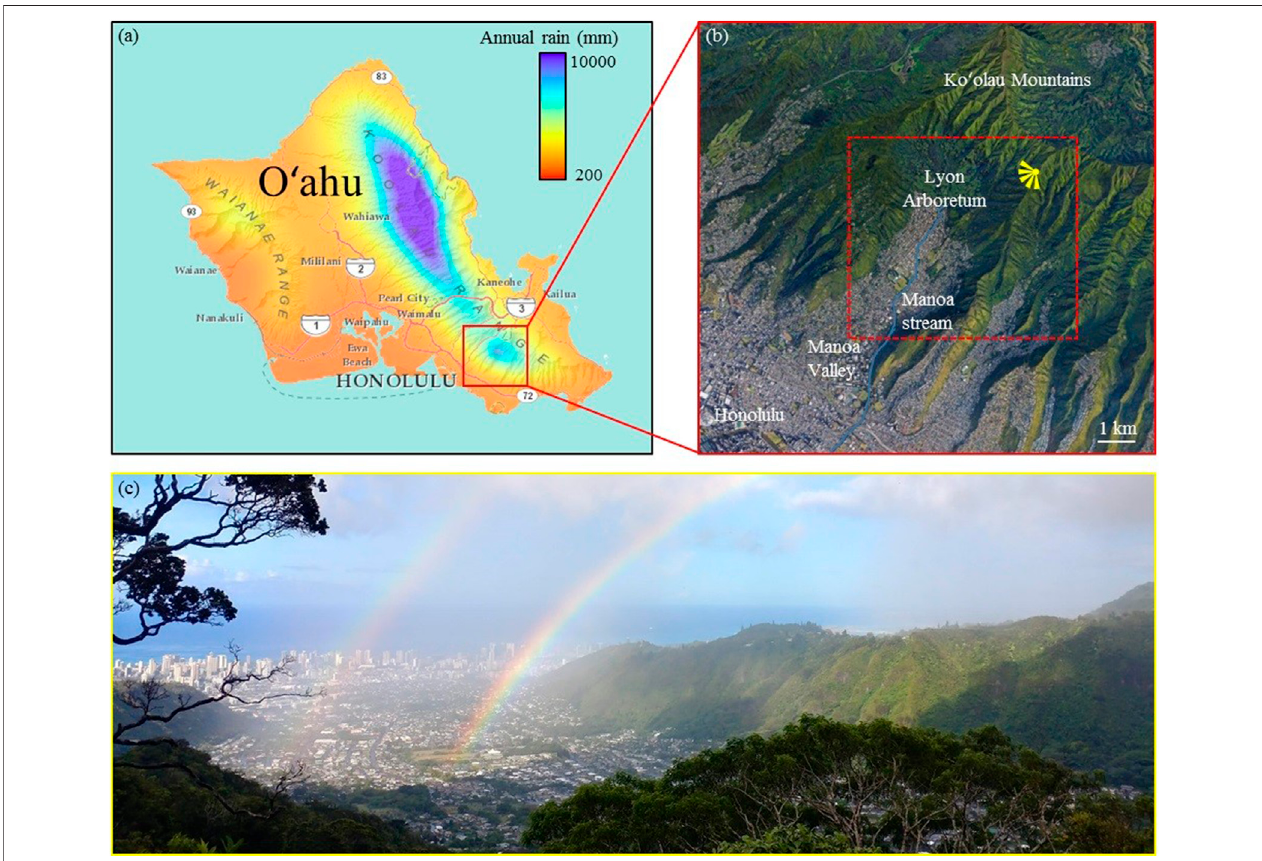
FIGURE 1 | Study area. (A) Mean annual rainfall in O ʻ ahu, adapted from http://rainfall.geography.hawaii.edu/interactivemap.html (Giambelluca et al., 2013). (B) Main morphological features of M (cid:1) anoa Valley (Map data © 2020: Google Earth, Maxar Technologies, Landsat, Copernicus). The area considered for rainfall mapping is denotedbythedashedredbox. (C) PictureofM (cid:1) anoaValleyillustratingthestudyareaandthelocalvariabilityofrainfall.Thelocationofthepicturetakenisdenotedbythe yellow symbol in (B) .